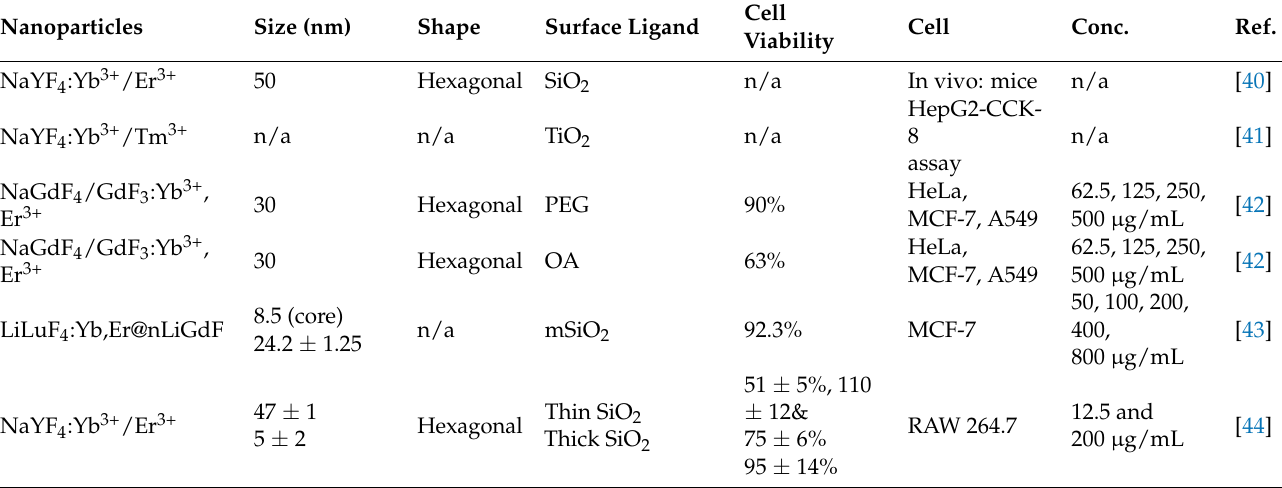
Figure 2. Various properties of upconversion nanomaterials and biological applications. Table 1. Cytotoxicity of upconversion nanomaterials in vitro.